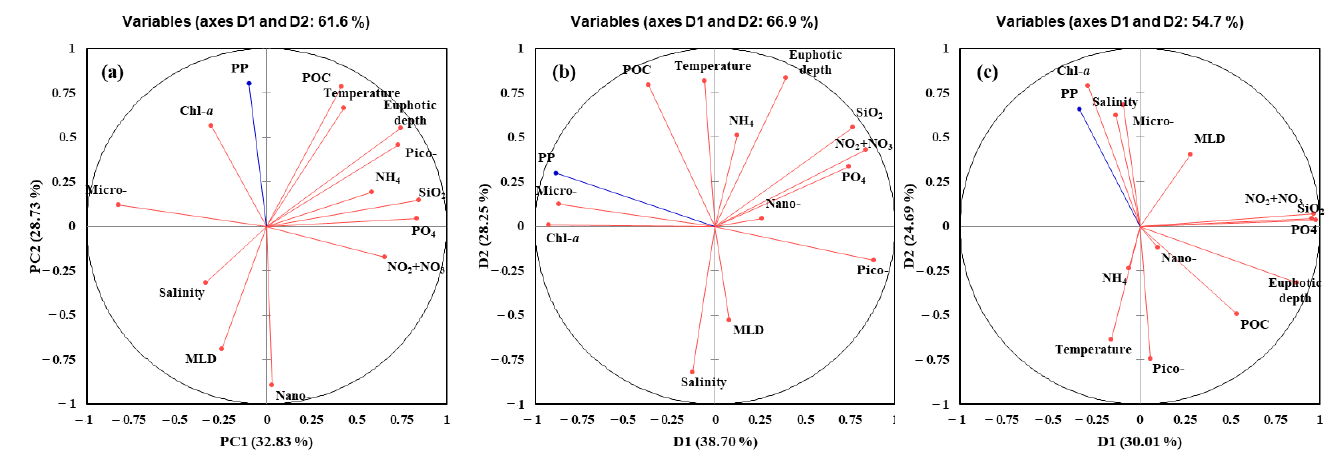
Figure 8. Principal components analysis (PCA) ordination plots showing primary production of phytoplankton in relation to environmental and biological conditions in the YS ( a ), the SS ( b ), and the EJS ( c ), 2018. Micro-, nano-, and pico- represent contributions of compositions of micro-, nano-, and pico-sized phytoplankton to total chl- a ; PP represents primary production.